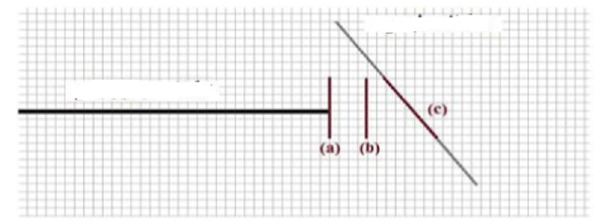
Fig. 4 A schematic of the position of the natural gap relative to the hydraulic gap in the three regions a, b and c